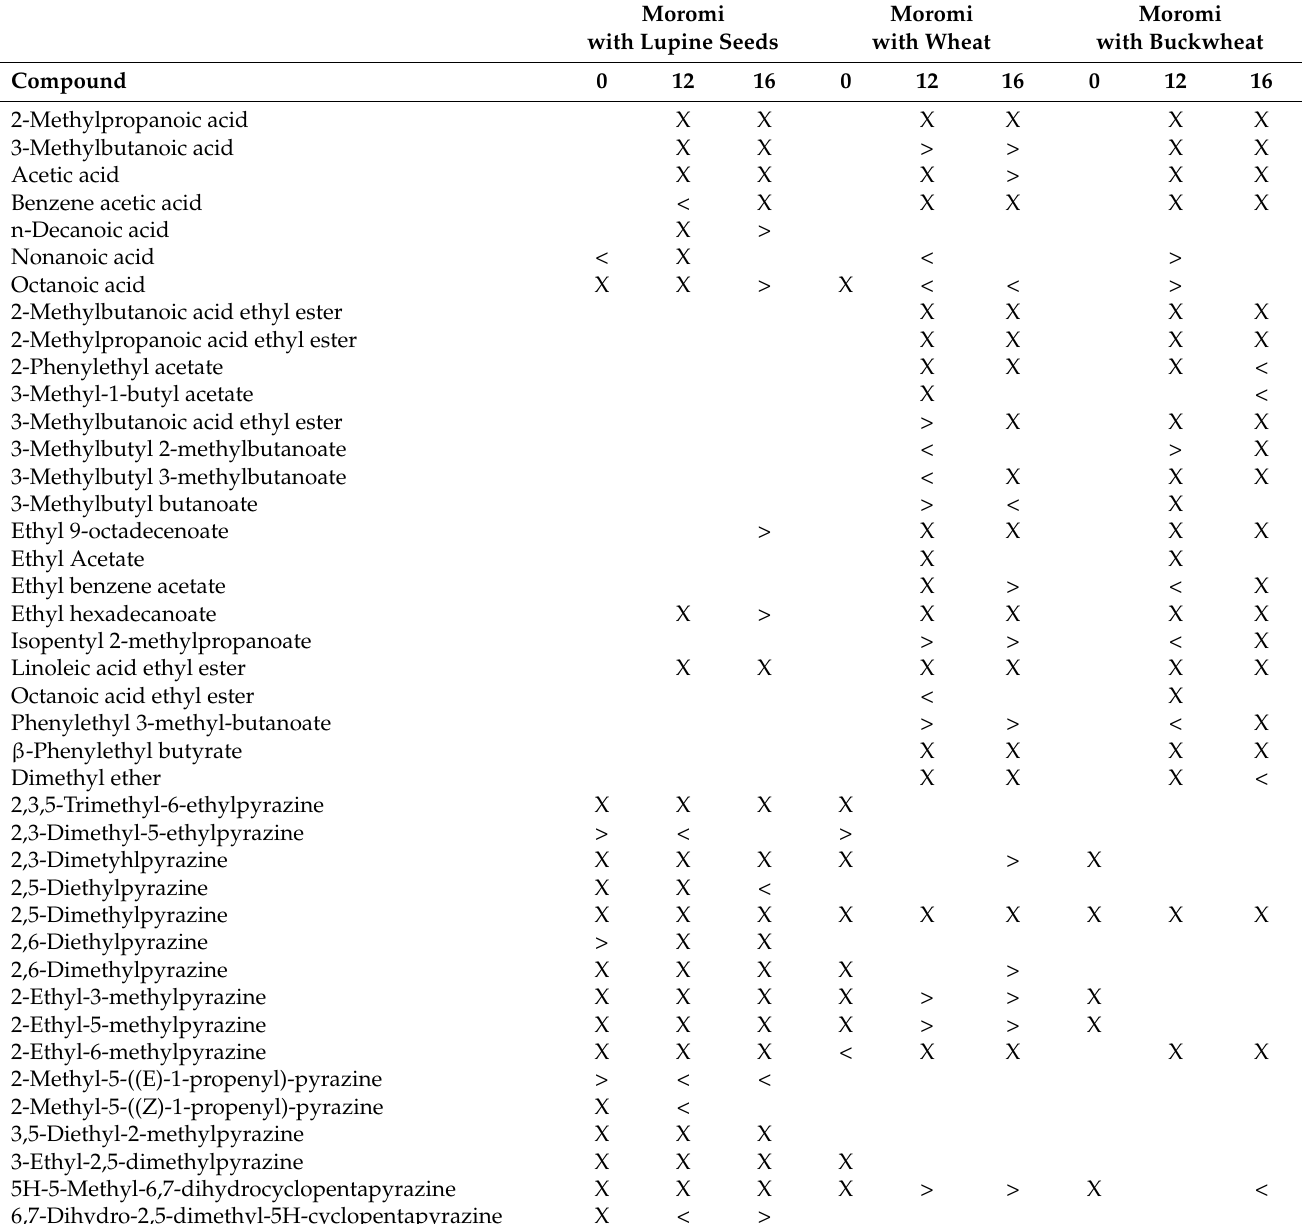
Table 1. Excerpt of volatile aromatic compounds measured via GC-MS headspace analysis after 0, 12, and 16 weeks of fermentation. Moromi Moromi Moromi with Lupine Seeds with Wheat with Buckwheat Compound 0 12 16